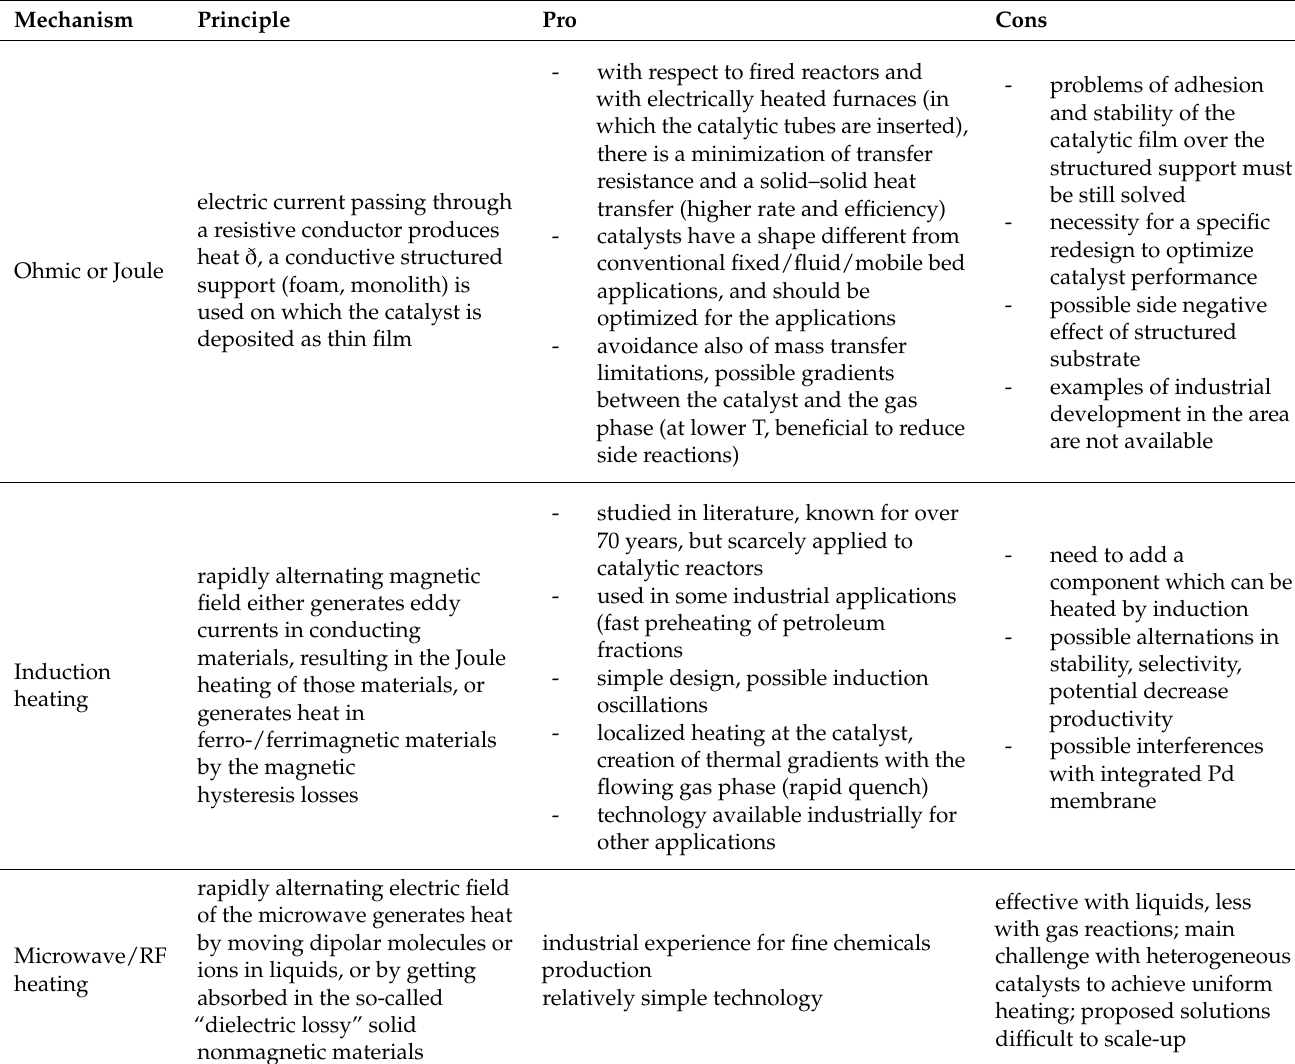
Table 1. Comparison of different alternatives for the electrification of chemical